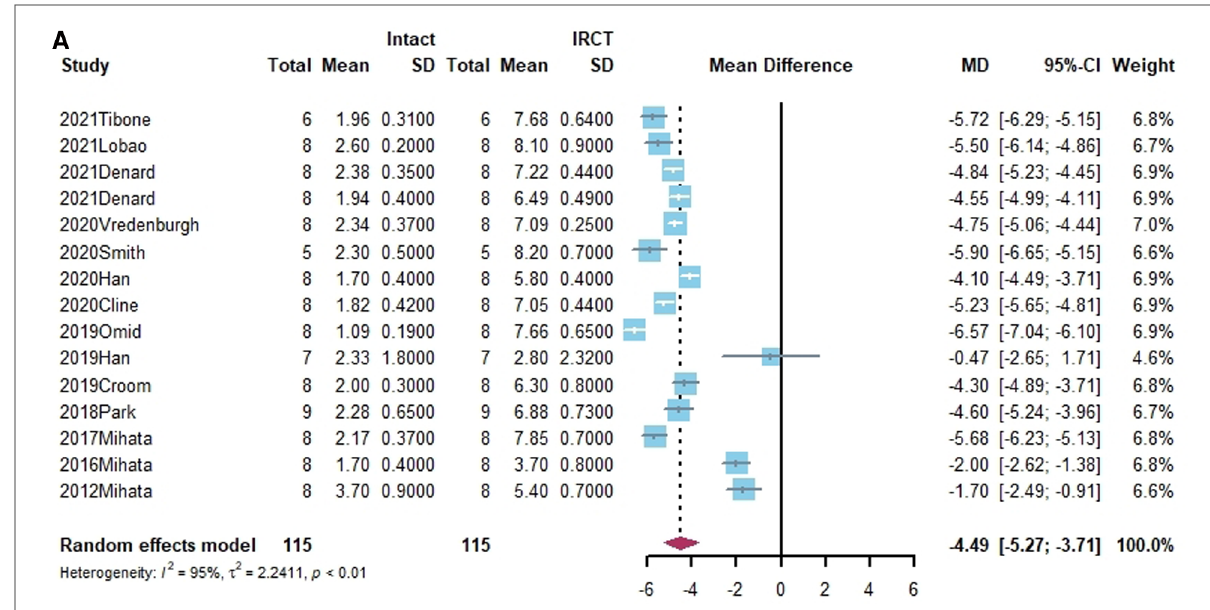
FIGURE 2 ( A ) forest plot comparing the mean difference (MD) of superior translation of humeral head between intact cuff and IRCT. ( B ) Forest plot comparing the mean difference (MD) of superior translation of humeral head between IRCT and SCR. ( C ) Forest plot comparing the mean difference (MD) of superior translation of humeral head between Intact cuff and